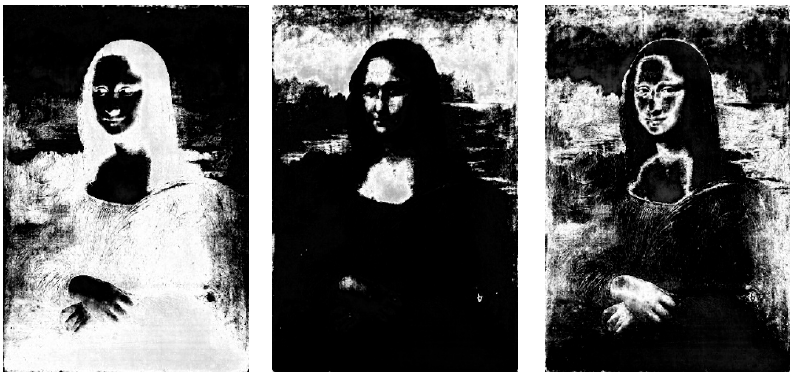
Figure 5. Mona Lisa B Band—compression rate 0.25—segmented images.